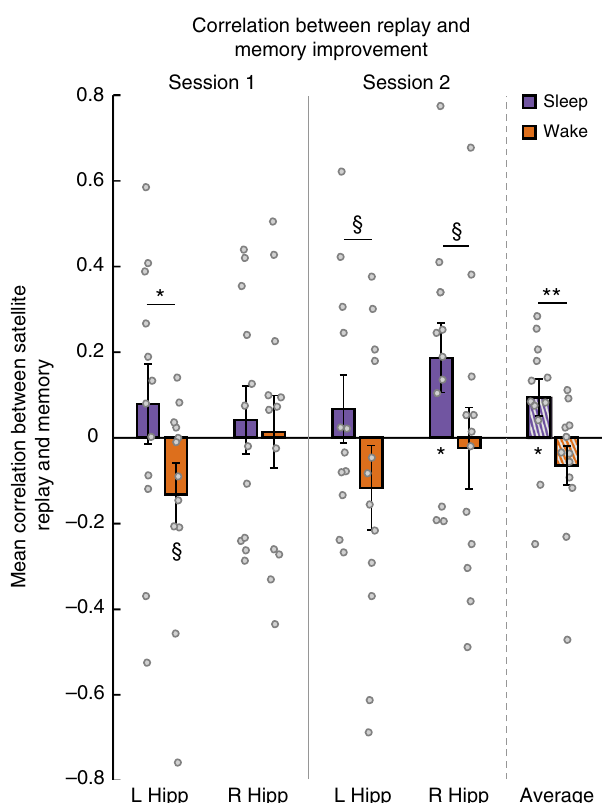
Fig. 5 Across-session replay – behavior relationships. Correlation between replay in each session and improvement in memory from the fi rst to second session, as well as the average for each group across sessions; § p < 0.1, * p < 0.05, ** p < 0.01, t -test, one-tailed for comparing Sleep to zero and Sleep to Wake. Error bars denote ± 1 SEM; n = 12 in each